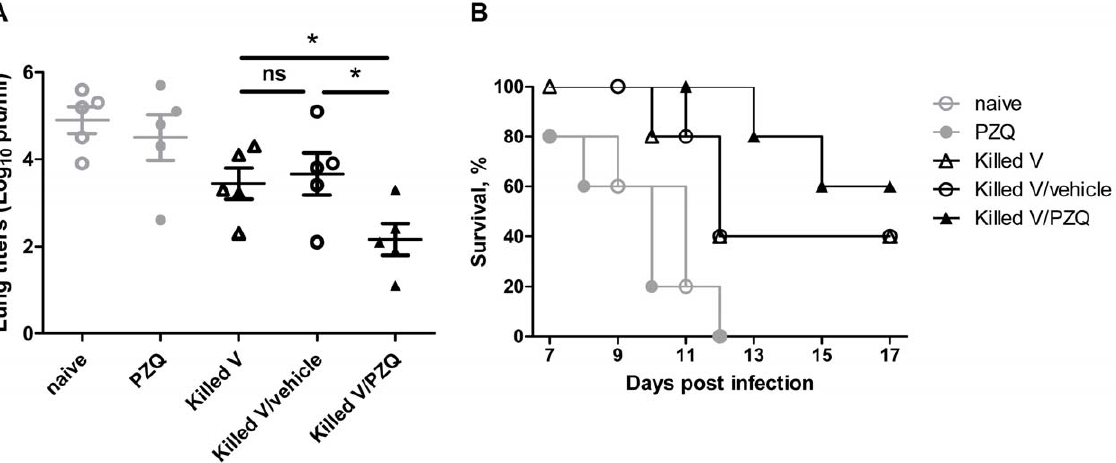
Figure 4. Protection against a highly pathogenic avian influenza virus H5N1 infection. Mice were challenged one month after vaccination (0.5 m g PZQ/0.1 m g antigen). (A) Viral loads in the lungs on day 7 after virus infection. (B) Survival curves. Data are analyzed from three separate experiments and each had 5 animals. *, p , 0.05.